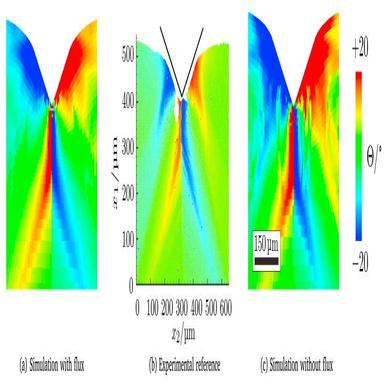
In-plane lattice rotation as experimentally obtained by Kysar et al. in comparison to the simulation results. Figure adopted from with permission from Elsevier.